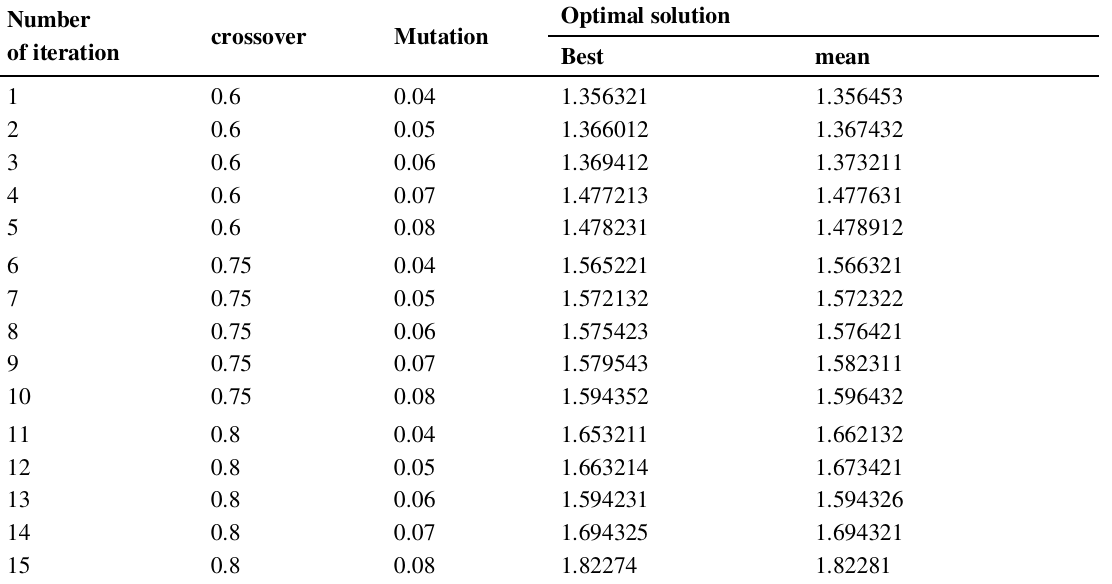
The optimum solution for several values of GA parameters